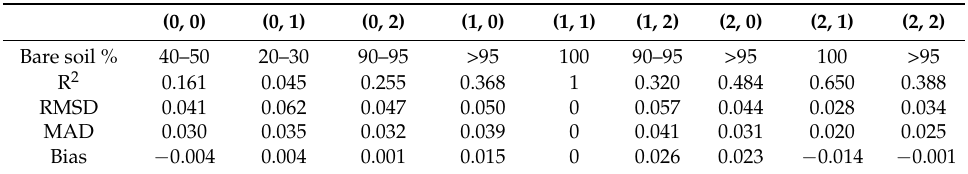
Table 4. Evaluation statistics calculated for comparing the disaggregated soil moisture of pixel (1, 1) shown in Figure 1c to the disaggregated soil moisture of the surrounding